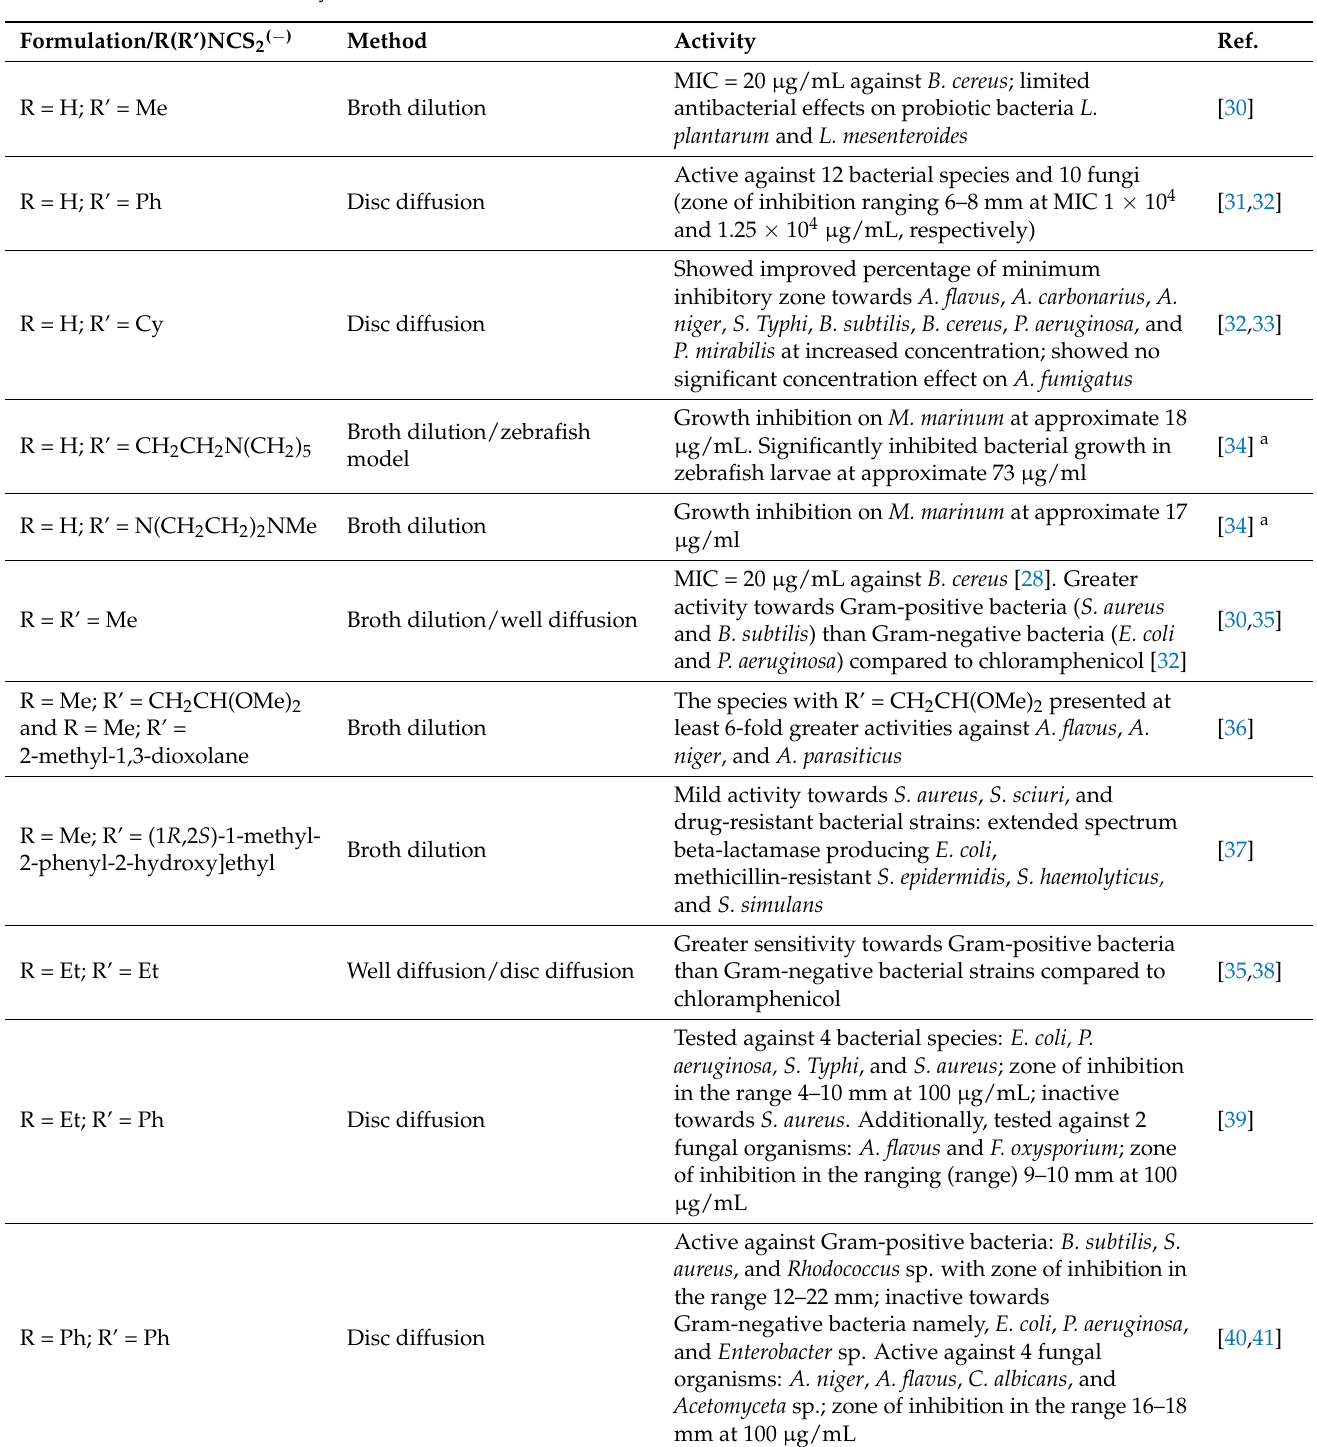
Table 1. Summary of antibacterial and antifungal activities exhibited by R(R’)NCS 2( − ) and Y(CH 2 CH 2 ) 2 NCS 2( − ) salts. MIC = minimum inhibitory